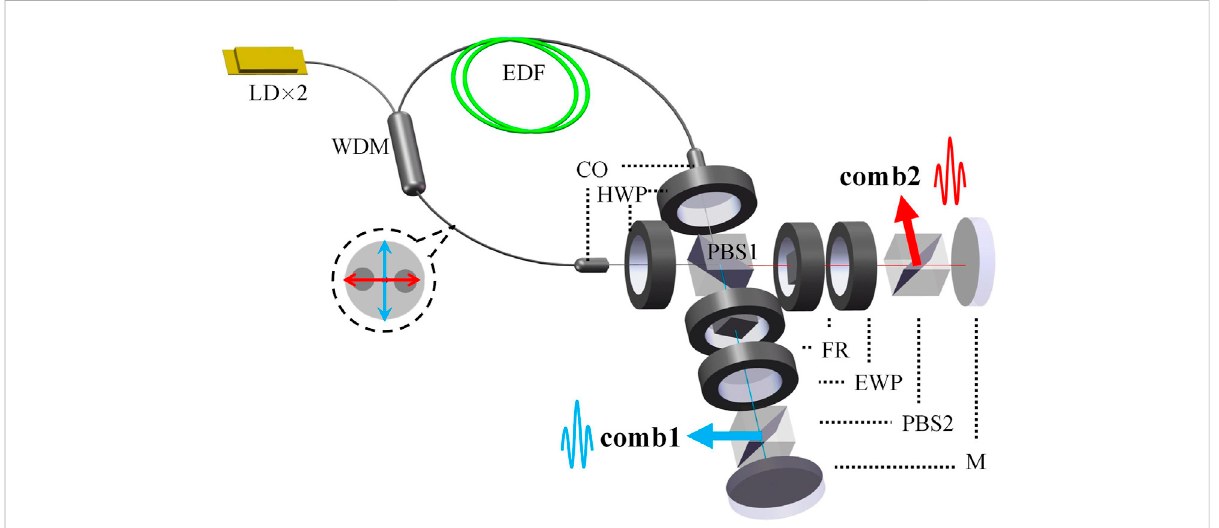
FIGURE 1 Schematicshowingthepolarization-multiplexeddual-comb fi berlaserbasedontheall-polarization-maintainingcavitycon fi guration.LD,laser diode; EDF, Er-doped fi ber; CO, fi ber collimator; WDM, wavelength division multiplexer (980 nm/1,550 nm); PBS, polarization beam splitter; HWP, half-wave plate; EWP, eighth-wave plate; FR, Faraday rotator; M, mirror.